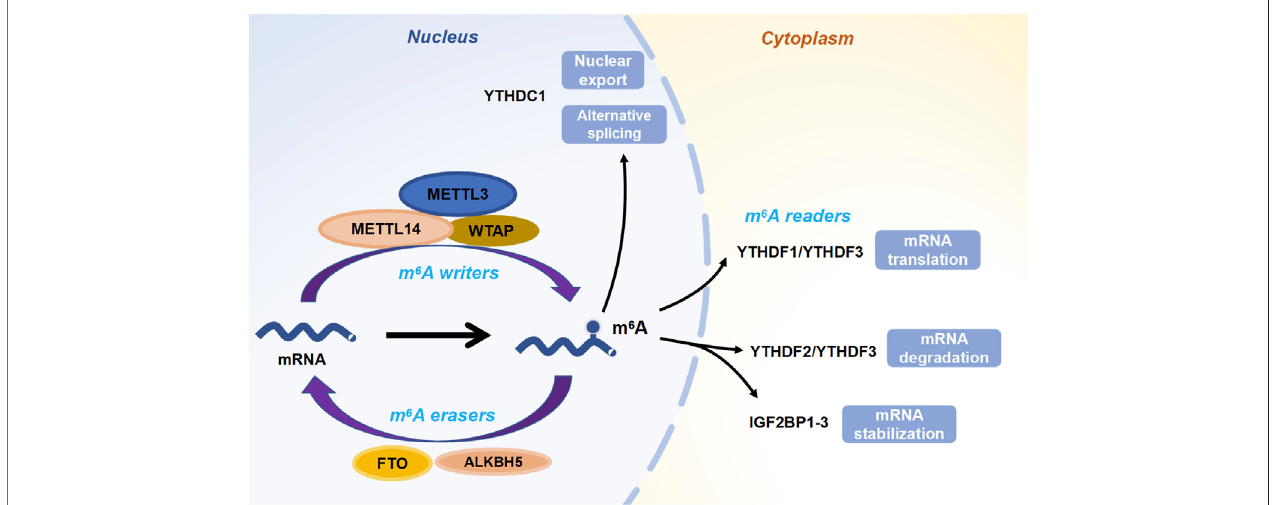
FIGURE1| The dynamic and reversible processes ofm 6 Amodi fi cation. “ Writers ” depositm 6 Amethylationon RNAs,while “ erasers ” removethem 6 Amarks.Then “ readers ” are responsible for regulating the fate of targeted